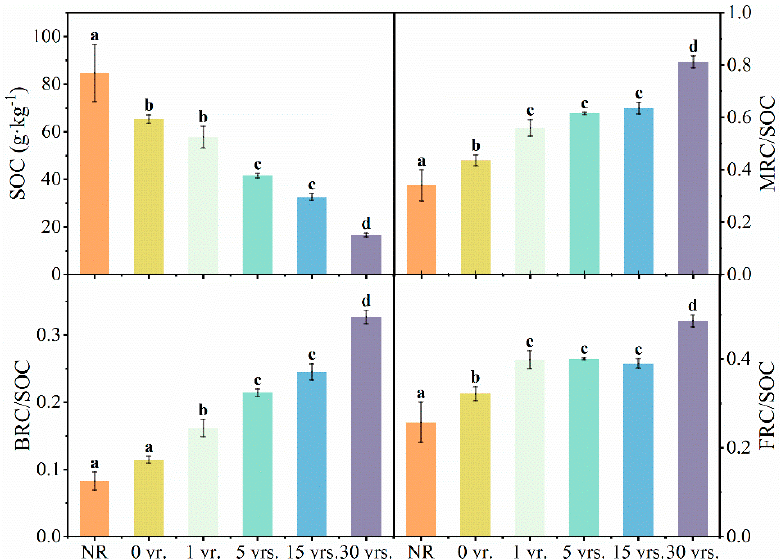
Figure 6. Contribution of fungal, bacterial, and microbial residue C to SOC in soils of natural reserved land and cultivated land. Note: Different letters indicate significant difference among the land use types at p < 0.05.